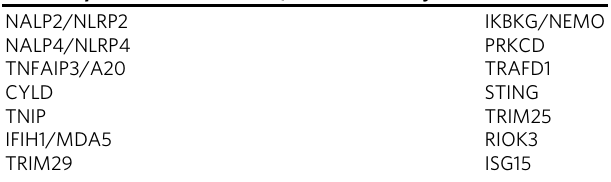
Table 3 Selection of proteins that play a direct role in the regulation of in fl ammatory and/or innate immune signaling pathways (Uniprot annotation) Selected proteins (in fl ammation/innate